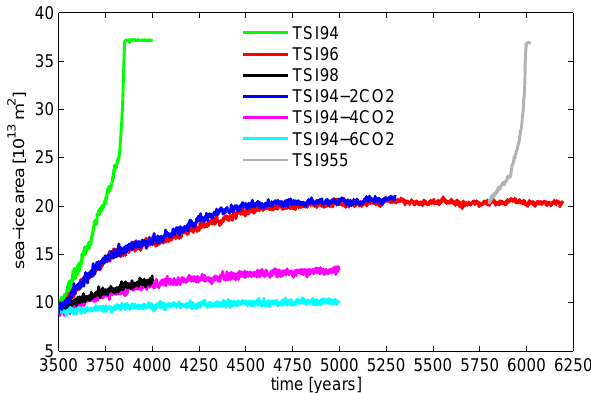
Fig. 5. Time evolution of annual-mean global sea-ice area as a re- sponse to an abrupt decrease of total solar irradiance (TSI) and, for some simulations, simultaneous increase of atmospheric carbon